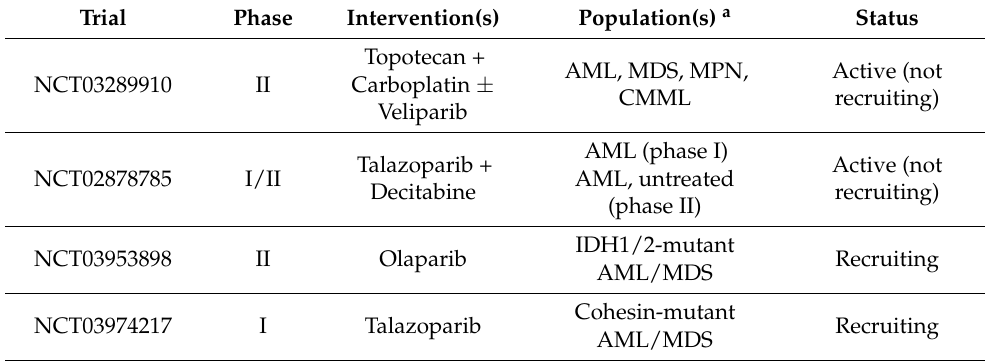
Table 4. Current Clinical Trials of PARP Inhibitors in Myeloid Neoplasms. Trial